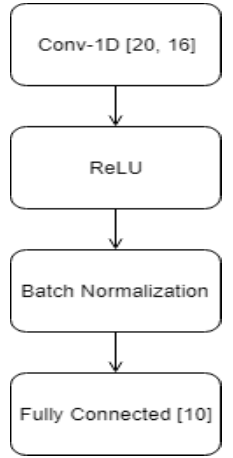
Figure 3. Convolutional Neural Network (CNN) architecture used in this work.